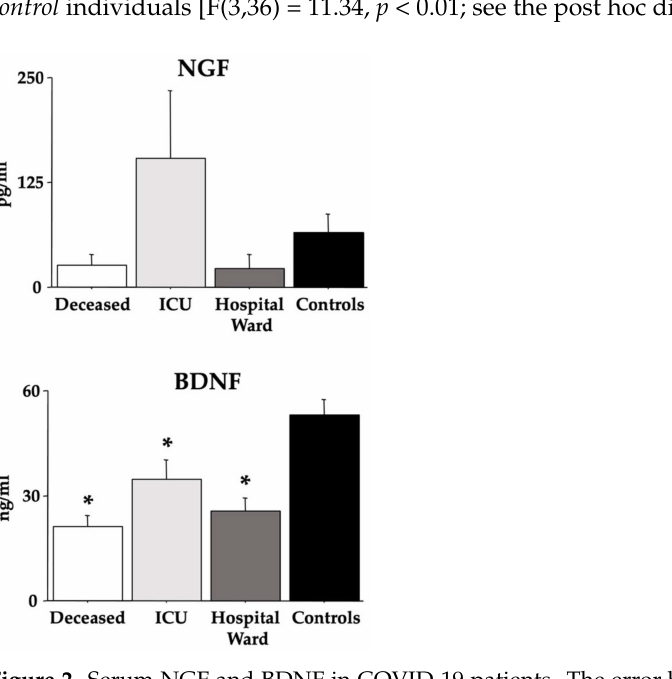
Figure 2. Serum NGF and BDNF in COVID-19 patients. The error bars indicate pooled standard error means (SEM) derived from the appropriate error mean square in the ANOVA. The asterisks ( p < 0.05) indicate post hoc differences with